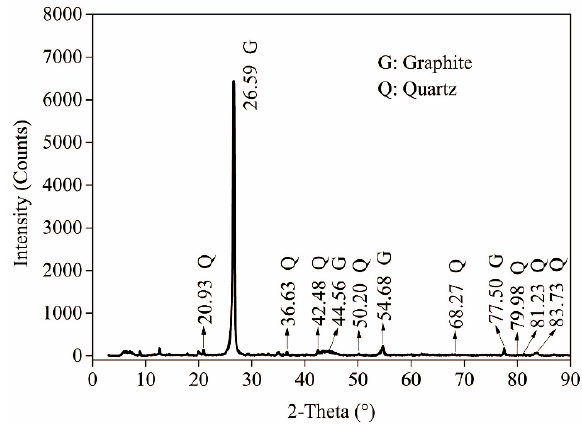
Figure 3. XRD patterns of the graphite ore.